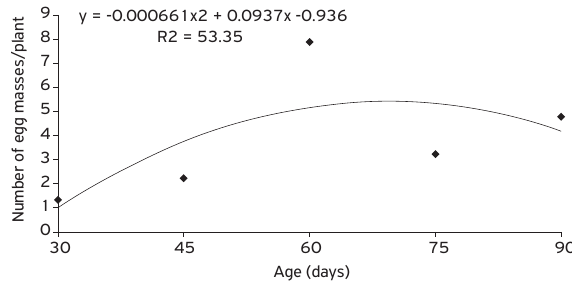
Figure 1. Relationship between cotton plant age and number of Spodoptera frugiperda egg masses in a free-choice Table 2. Numbers (mean ± standard deviation) of Spodoptera frugiperda egg masses in different cotton plant parts, BRS Ita 90 variety. Plant parts Leaves